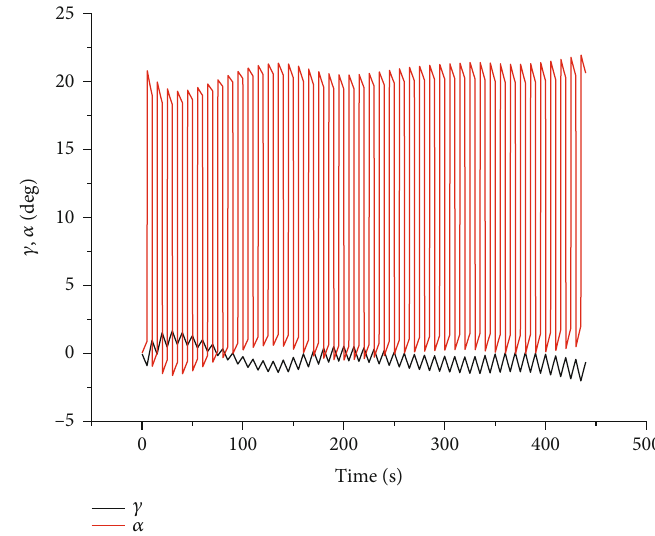
Figure 16: Elevation angle and angle of attack with self-oscillation strategy.